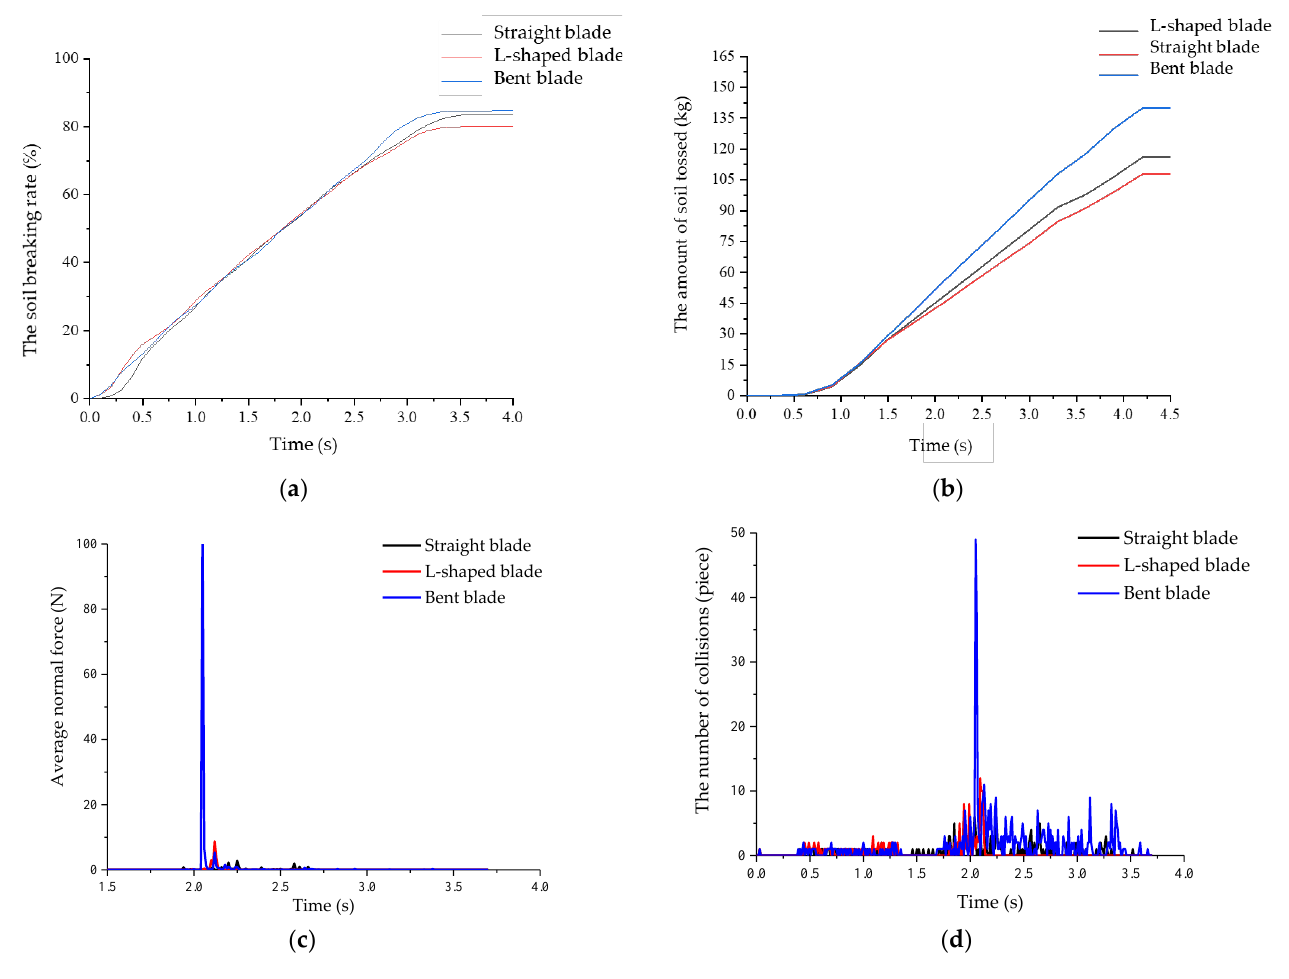
Figure 15. Changes in the soil breaking rate, amount of soil tossed, average normal force, and number of collisions with time. ( a ) Changes in the soil breaking rate with time; ( b ) Changes in the amount of soil tossed with time; ( c ) Changes in the average normal force on the tiger nuts with time; ( d ) Changes in the number of collisions between tiger nuts with time.